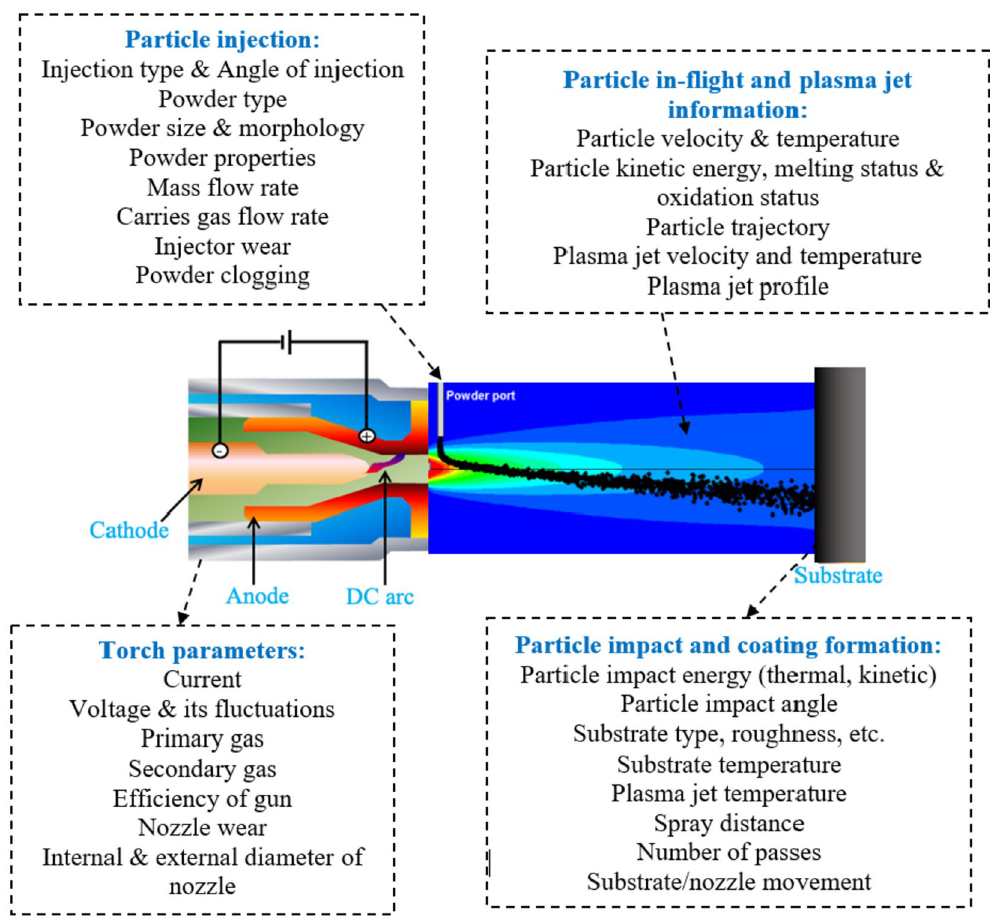
Fig. 1 Parameters and variables in a typical